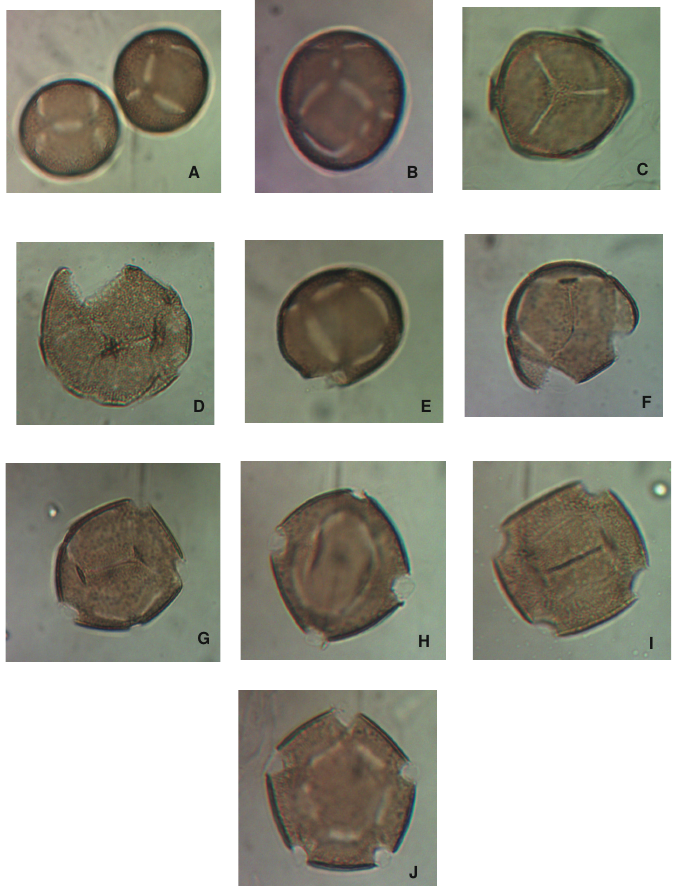
Fig. 4. Pollen grains of T . paniculatum (×400 ) A – C. Acolpate, D & E. Monocolpate, F. Bicolpate, G. Tricolpate, H & I. Tetracolpate J. Pentacolpate